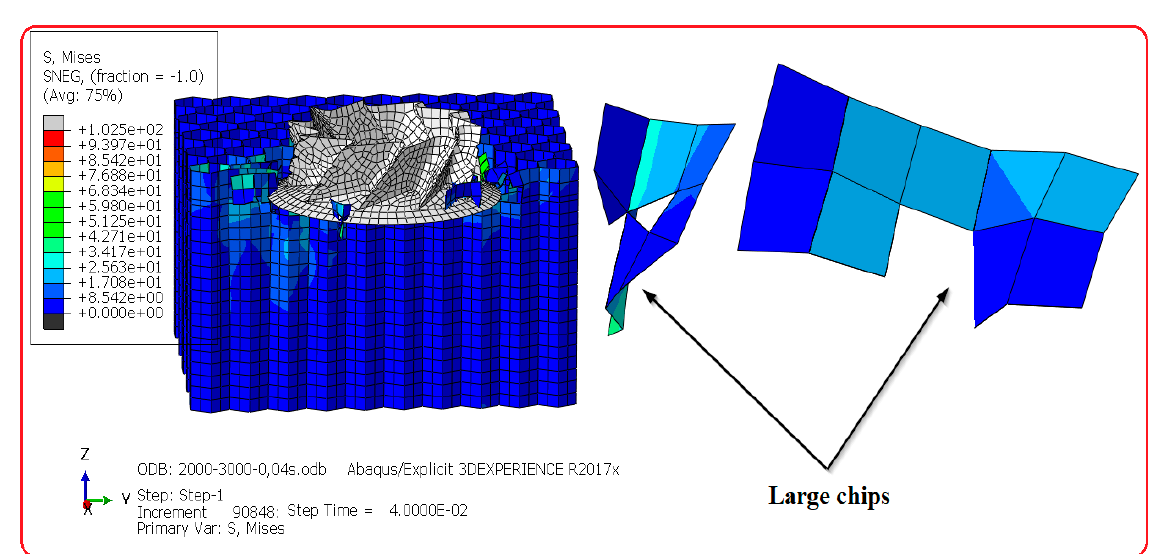
Figure 13. Resulting chip size by the diameter-cutting blade of 18.3 mm.